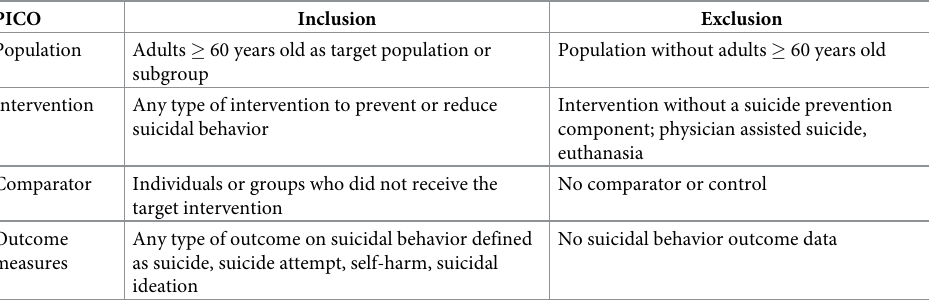
Table 1. Inclusion and exclusion